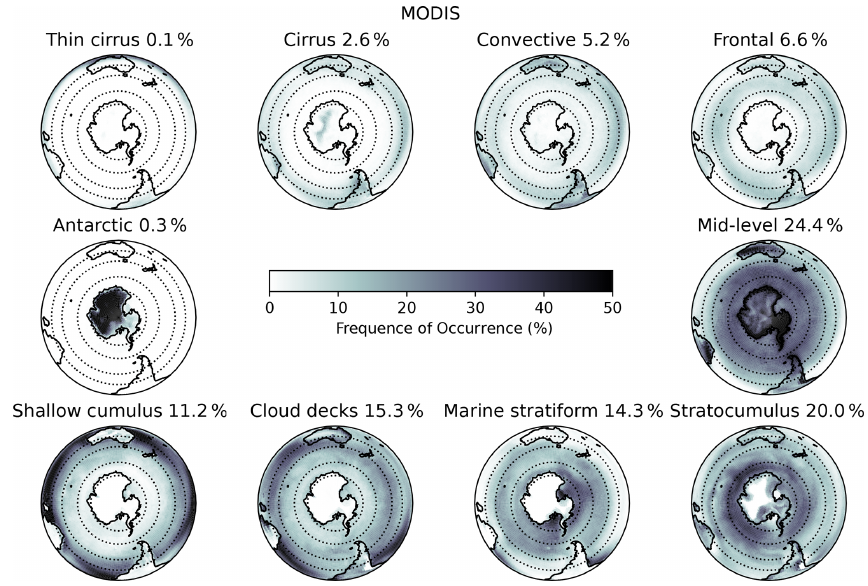
Figure 3. Spatial maps of the relative frequency of occurrence for each MODIS cloud cluster found by k -means clustering. Note that the three Antarctic clusters have been merged into one. The dashed lines represent the boundaries of the mid-latitude, sub-polar and polar regions as defined in Sect. 3. The numbers in each title represent the mean frequency of occurrence for each cloud regime (in time and space) over the SO region.